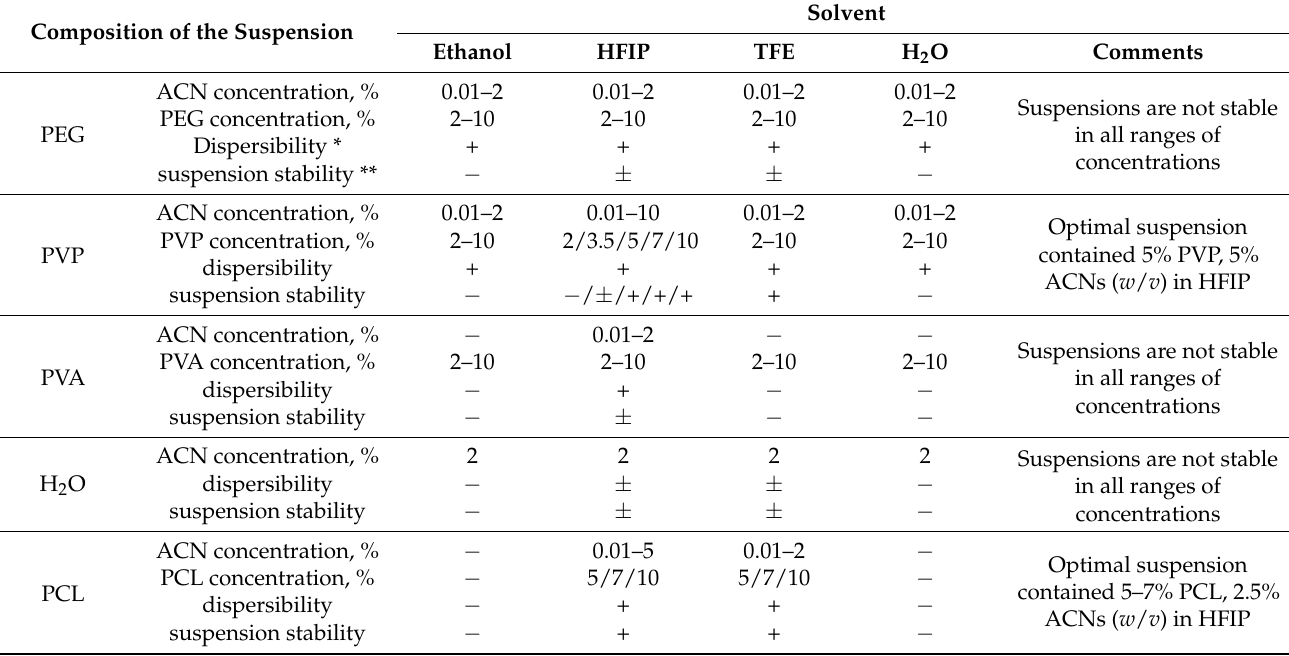
Table 1. Properties of the suspensions (% weight/volume) prepared and assessed for